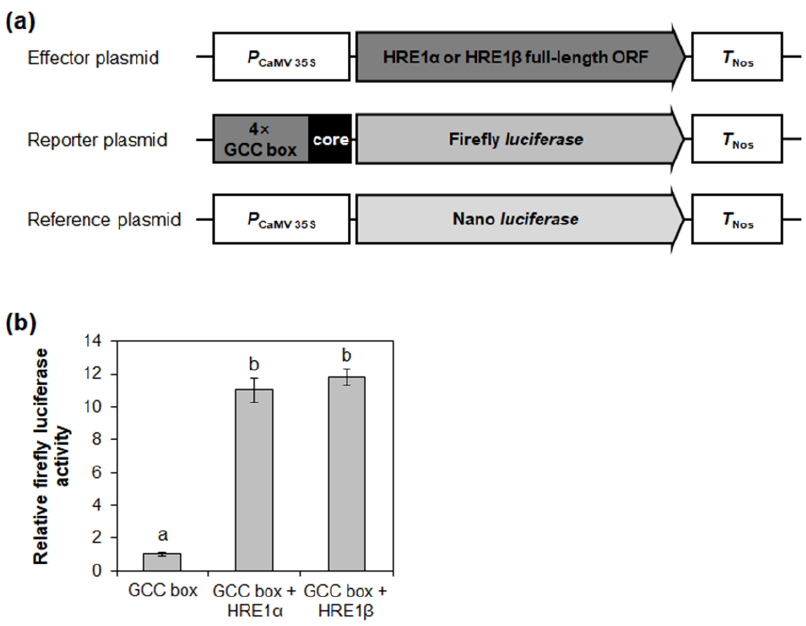
Figure 8. Transactivation assay of HRE1α and HRE1β via GCC box. ( a ) The schematic maps of the effector plasmid, reporter plasmid, and reference plasmid for the transactivation assay of HRE1α and HRE1β via GCC box. ( b ) The relative firefly luciferase activity in Arabidopsis protoplasts. The transformation efficiency was normalized with Nano luciferase activity of the reference plasmid. The normalized firefly luciferase activity of negative control was set as 1. The empty effector plasmid was used as a negative control. The data shown are means ± S.D. ( n = 3). The data were analyzed with one-way ANOVA using Tukey’s multiple comparison test. Different letters indicate significant differences ( p < 0.05).